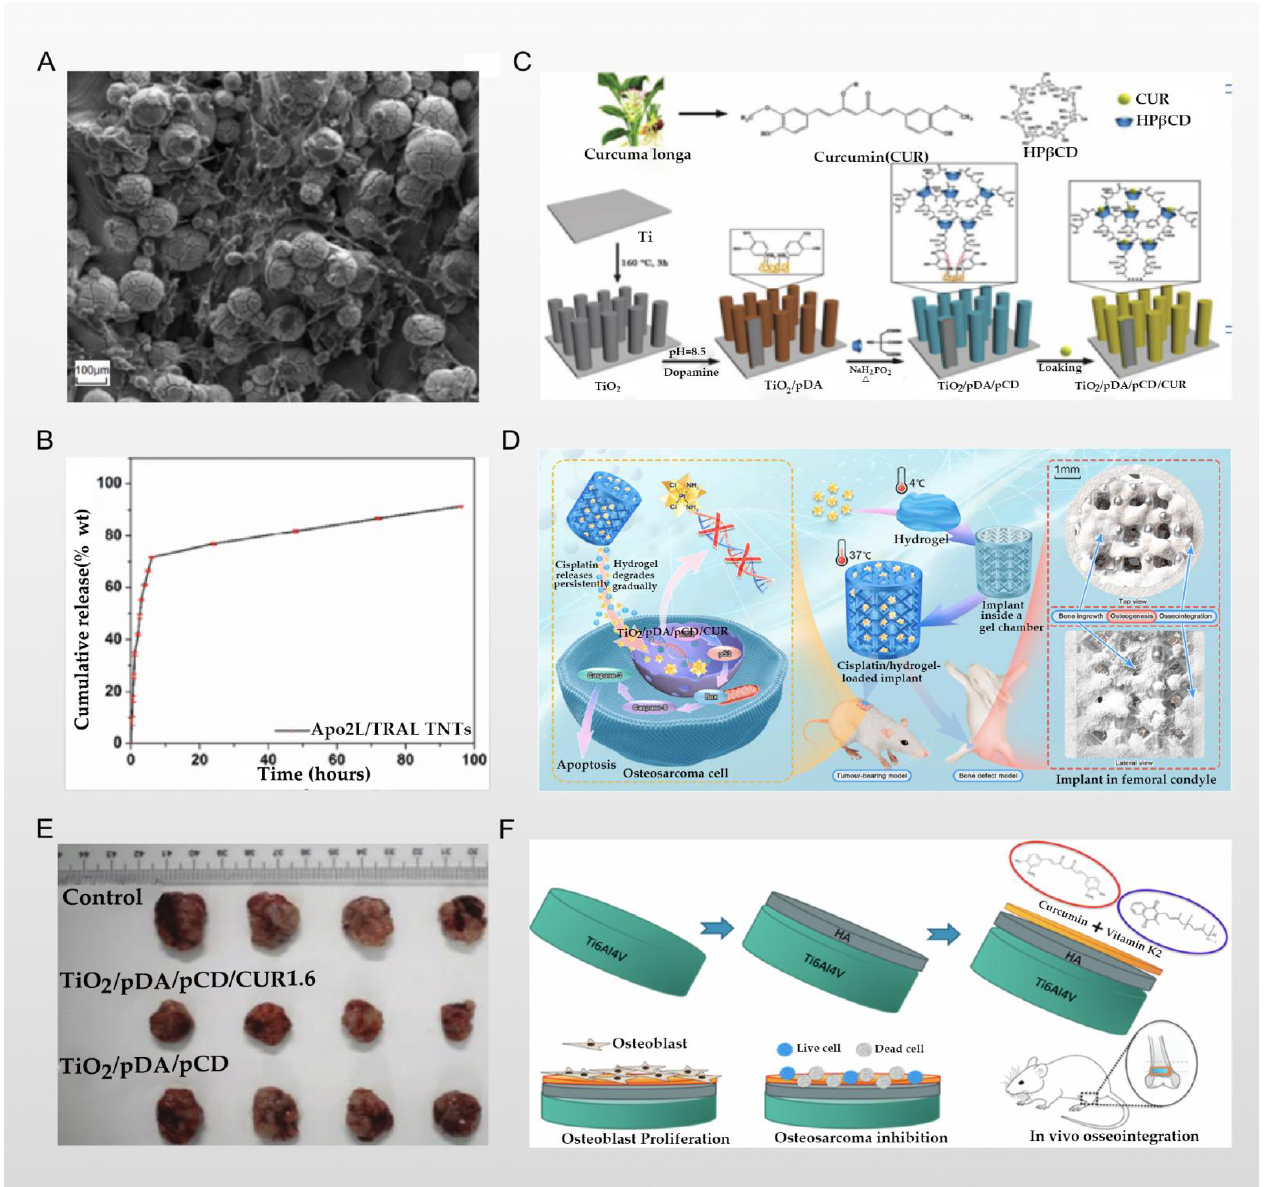
Figure 4. ( A ) Adhesion and aggregation of fibroblasts under an electron microscope; reprinted with permission from [31]; copyright 2017 American Chemical Society. ( B ) In vitro drug release of different drugs loaded onto TNT-3D-Ti implants (Apo2L/TRAIL); reprinted with permission from [31]; copyright 2017 American Chemical Society. ( C ) The experimental scheme of Zhang et al; reprinted with permission from [74]; copyright 2019 WILEY-VCH Verlag GmbH & Co. KGaA, Weinheim. ( D ) The experimental scheme of Jing et al; reprinted with permission from [76]; copyright 2021 Zehao Jing et al. ( E ) Images of tumors collected from tumor-bearing mice after various treatments; reprinted with permission from [74]; copyright 2019 WILEY-VCH Verlag GmbH & Co. KGaA, Weinheim. ( F ) The experimental scheme of Sarkar et al.; reprinted with permission from [77]; copyright 2020 American Chemical